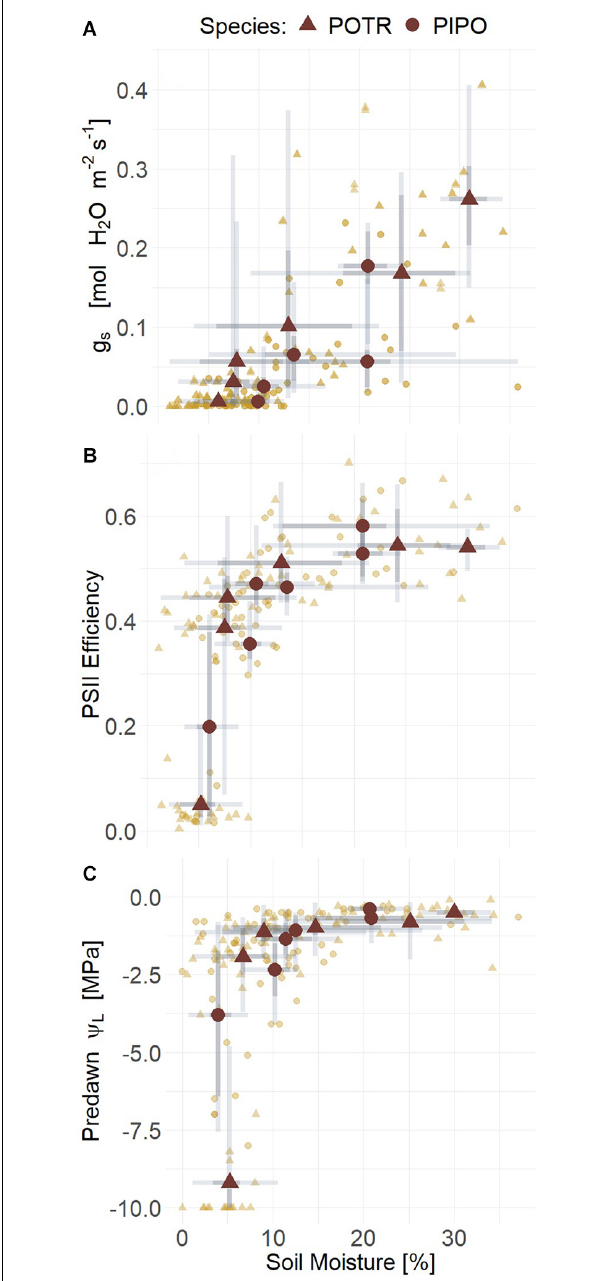
FIGURE 3 | Aspen (POTR, triangles) and ponderosa pine (PIPO, circles) measurements of stomatal conductance (g s , A ), photosystem II efficiency ( F v (cid:48) /F m (cid:48) , B ), and leaf water potential ( (cid:57) L , C ) from combined drought experiments, moderate to severe. Individual replicates (gold) and the prior data maximum likelihood estimates (MLE, red) for respective days of drought are presented. Data 50% (dark gray) and 94% (light gray) creditable intervals corresponding to days of drought at each time point ( n =